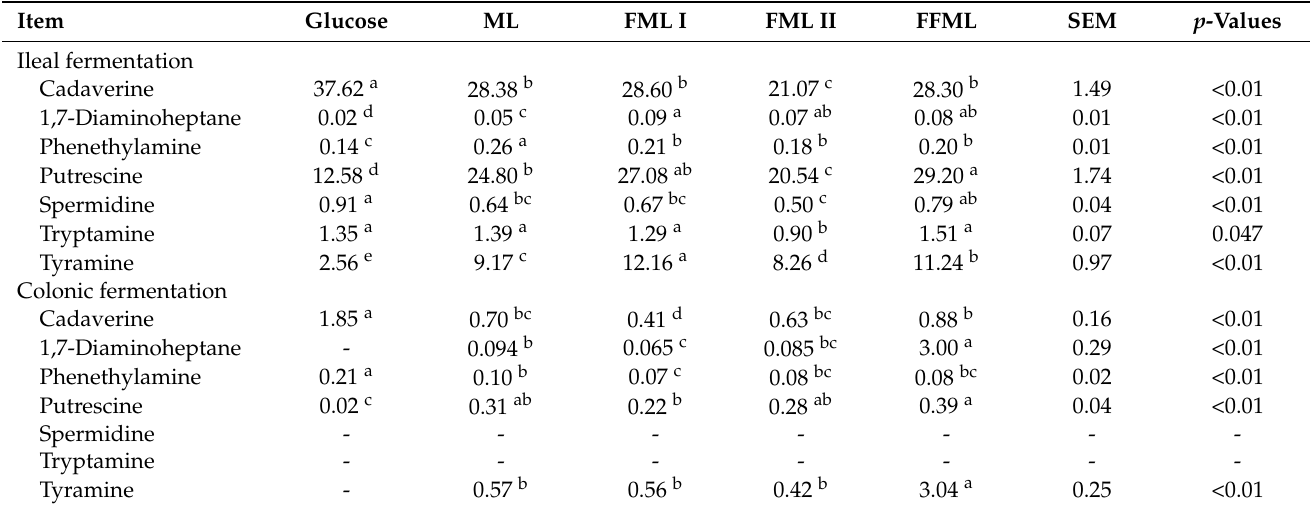
Table 7. In vitro bioamine concentrations of Mao-tai lees and fermented Mao-tai lees in the ileum and colon ( µ